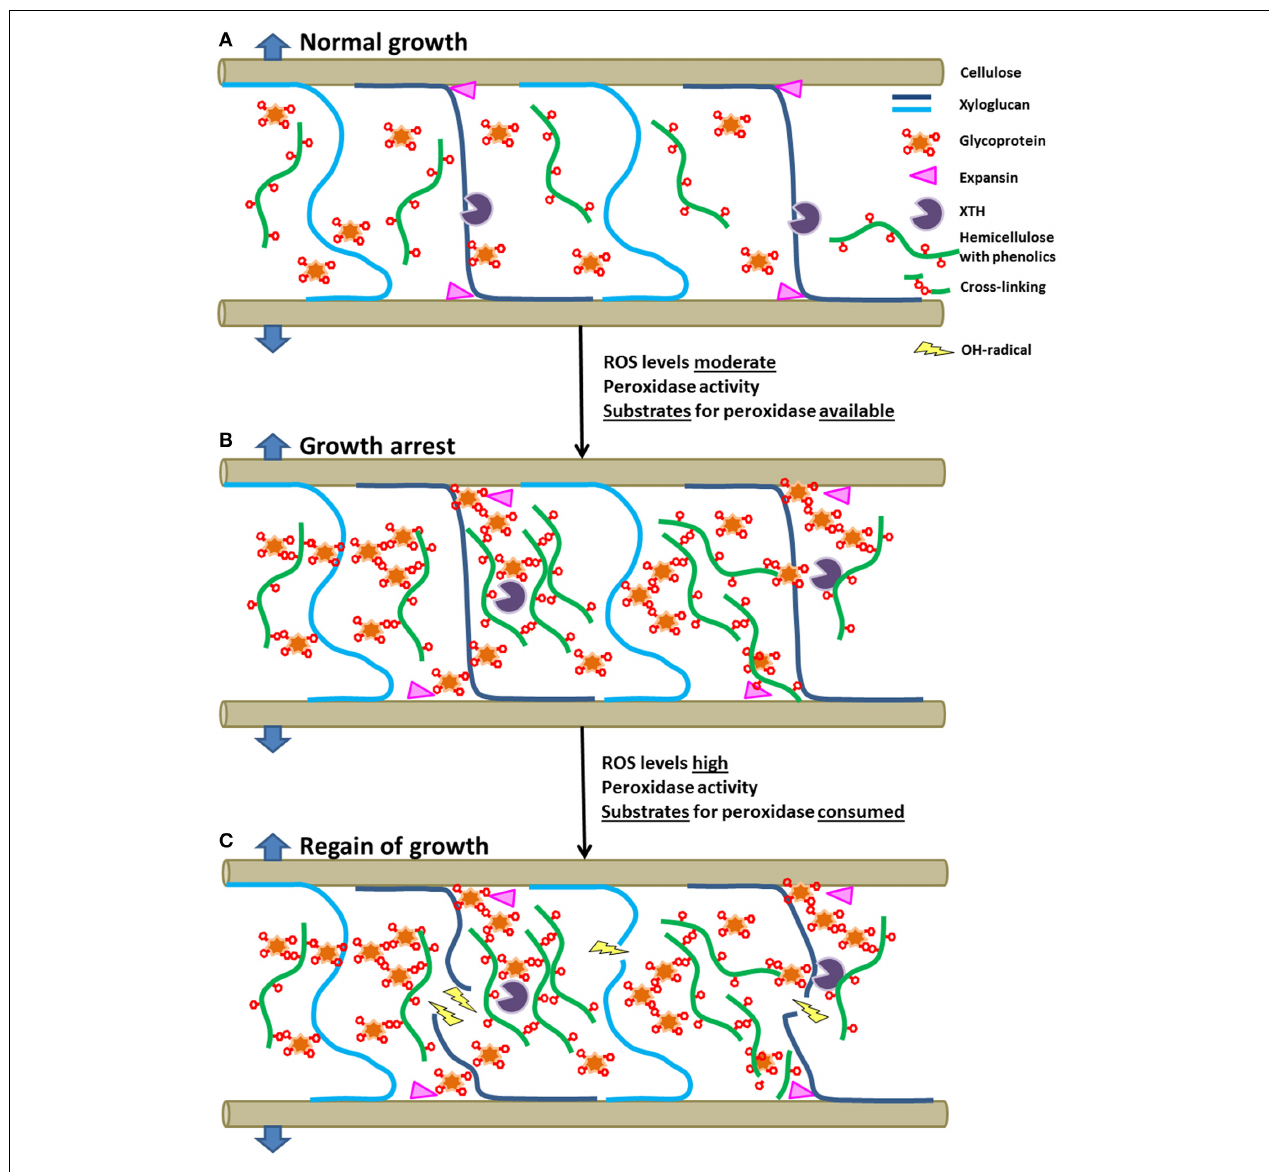
FIGURE 2 | Model of growth of cell walls in unstressed conditions (A), plants under abiotic stress showing growth arrest (B), and tolerant plants overcoming the growth arrest by using ROS-mediated cleavage of cell wall polymers (C) (see text for